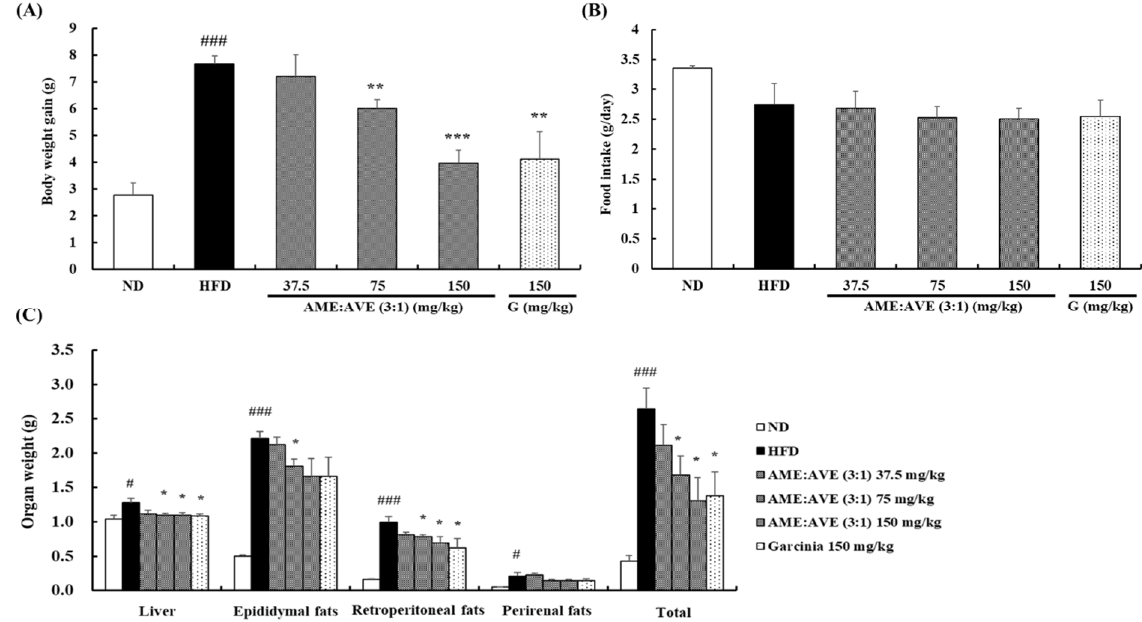
Figure 5. Effects of Atractylodes macrocephala and Amomum villosum extracts (3:1) on body and organ weights in high-fat diet-induced obesity in mice. ( A ) Body weight gain. ( B ) Food intake. ( C ) Organ weight. ND, normal-diet group; HFD, high-fat diet group. # p < 0.05, and ### p < 0.001 vs. ND group. * p < 0.05, ** p < 0.01, and *** p < 0.001 vs. HFD group.